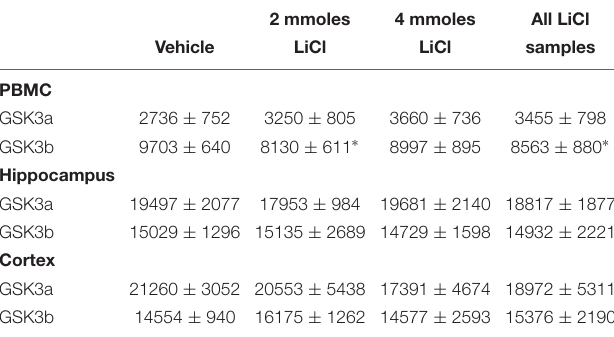
TABLE 4 | GSK3 specific activity (measured by IP assay) in rat tissue